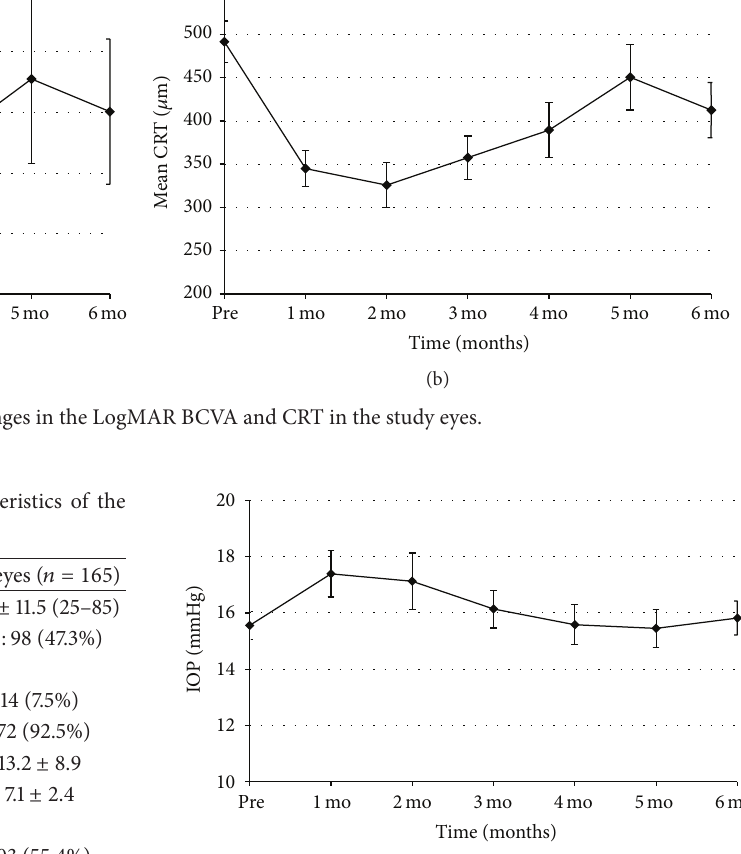
Figure 2: Mean changes in the IOP in the study